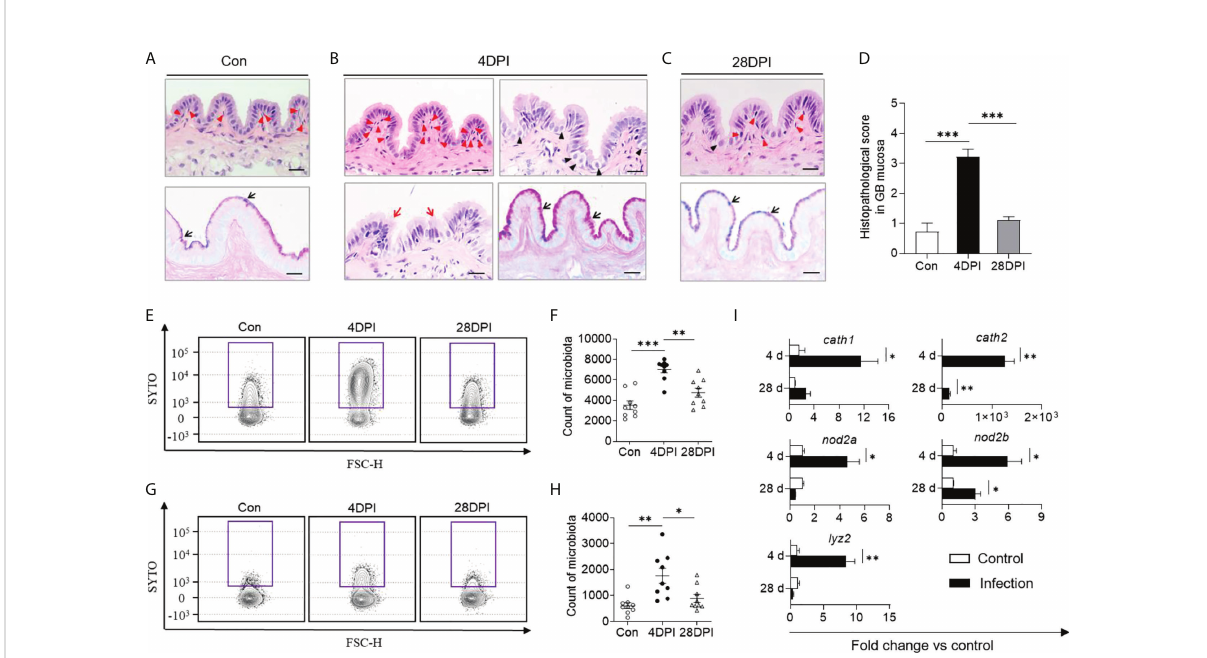
FIGURE 3 Anti-bacterial response occurred in GB following IHNV infection. Histological examination (H & E and AB-PAS) of GB organ from control (Con, A ), and IHNV-infected fi sh at 4 DPI (B) , and 28 DPI (C) . Red arrowheads indicate lymphocytic cells; Black arrowheads indicate distended columnar cells with excessive mucoid secretion; Red arrows represent disrupted mucosal epithelium with loss of continuity; Black arrows indicate the reaction with AB-PAS. Scale bars, 20 m m. (D) Pathology score of GB from control and IHNV-infected fi sh at 4 DPI and 28 DPI ( n = 6). Statistical differences were evaluated by One-way ANOVA. Flow cytometry analysis microbiota of GM (E) and bile (G) samples stained with SYTO BC Green from control and IHNV-infected fi sh at 4 and 28 DPI. Counts of positive microbiota in the GM (F) and bile (H) samples from control and IHNV-infected fi sh at 4 and 28 DPI ( n = 9 fi sh per group). Statistical differences were evaluated by One-way ANOVA. (I) qPCR analysis of antimicrobial peptides (AMP) genes in GB organ from control and IHNV-infected fi sh at 4 and 28 DPI. Expression levels in IHNV- infected fi sh were normalized to those in control fi sh, which were set as 1 ( n = 8 fi sh per group). Statistical analysis is performed by unpaired Student ’ s- t test. Data are representative of at least two independent experiments (mean ± SEM). * p < 0.05, ** p < 0.01, *** p <